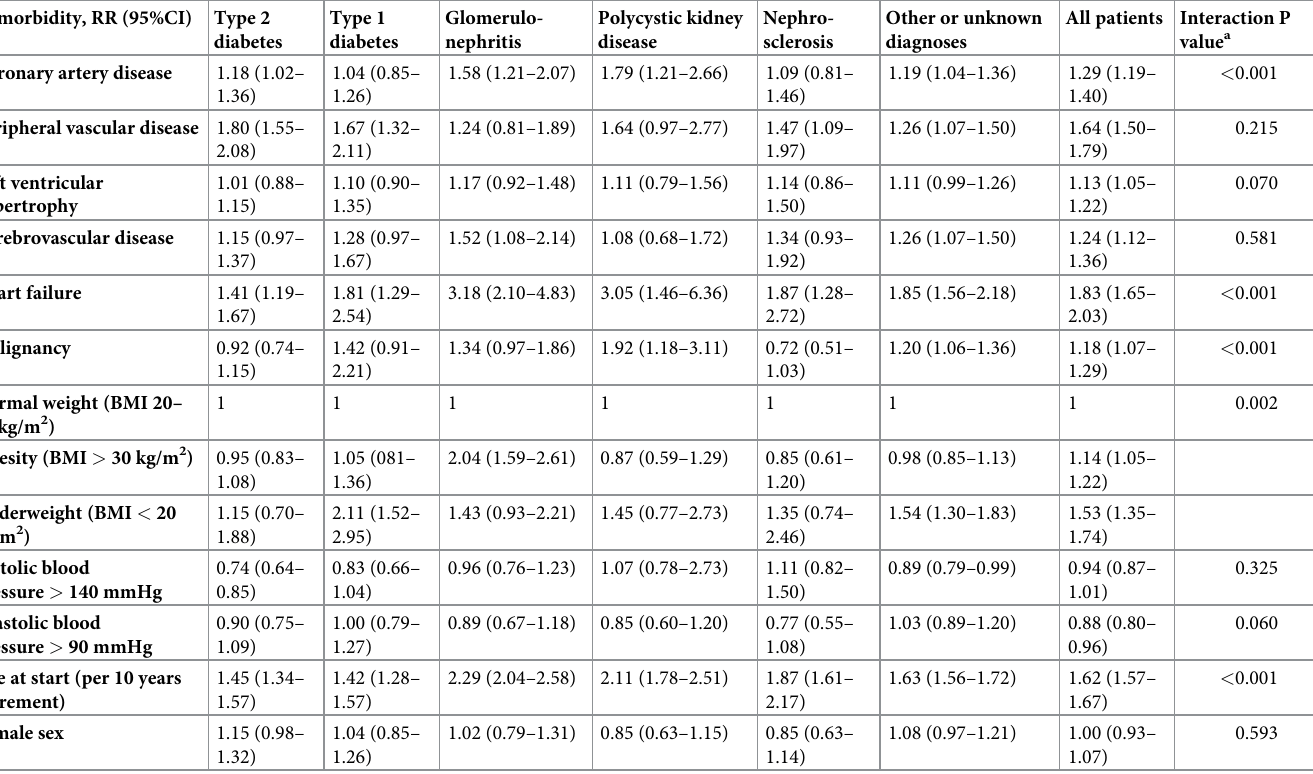
Table 3. Multivariable model of comorbidities’ effect on relative risk of death according to primary kidney